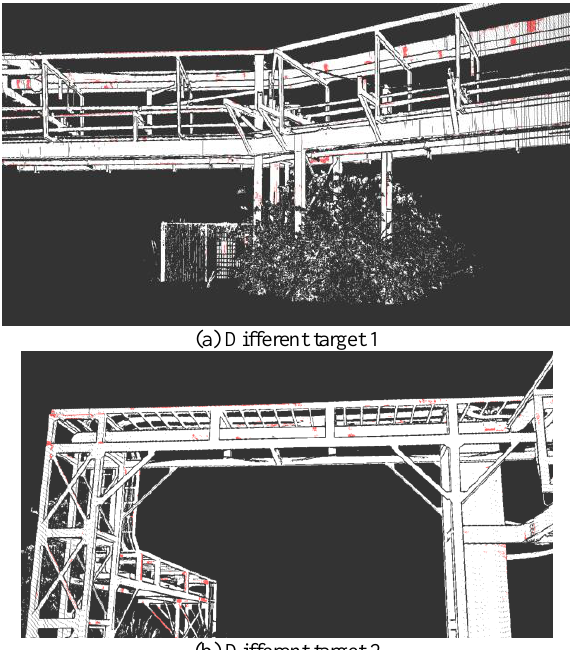
Figure 13. Detection result by proposed method for scene in Figure